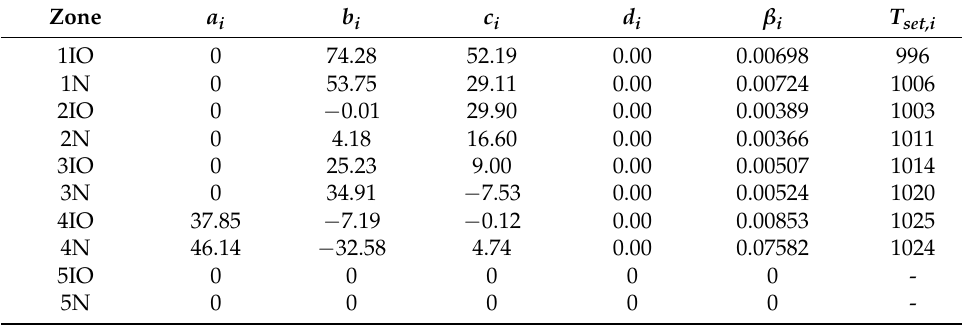
Table 8. Optimized coefficients for